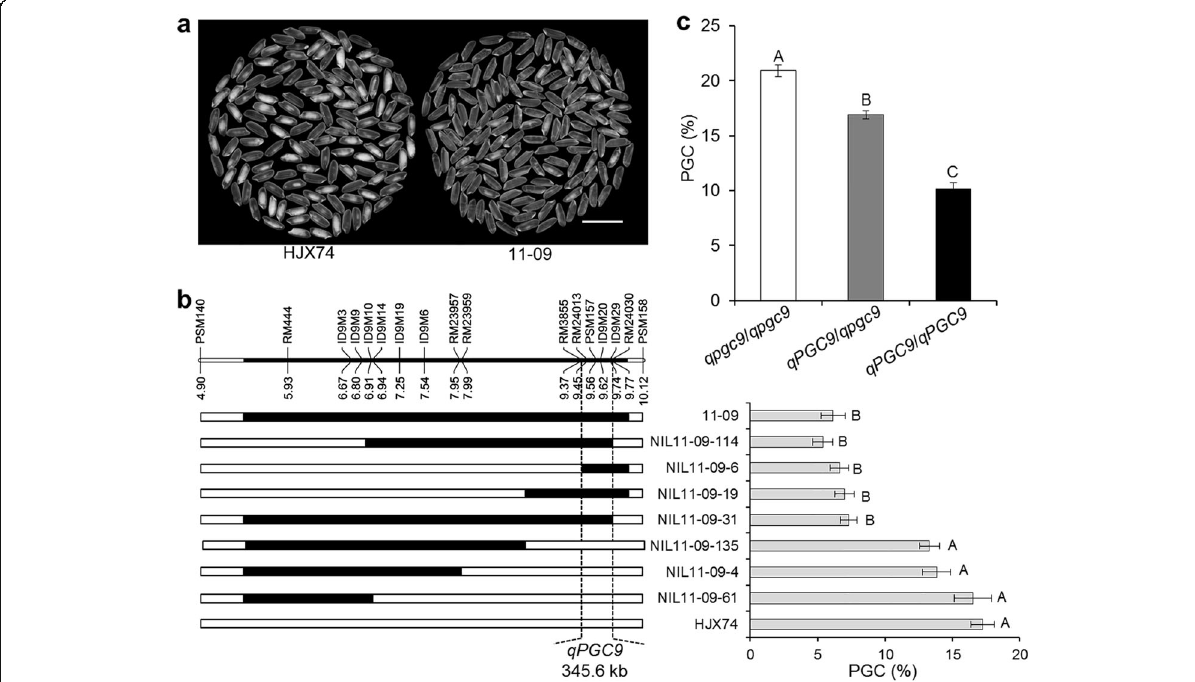
Fig. 2 Substitution mapping of qPGC9 for grain chalkiness . a , The head rice appearance of the HJX74 and 11 – 09. Scale bar: 1 cm. b , Substitution mapping of qPGC9 . The positions of substitution segments and the PGC of 11 – 09 and its NILs are shown, with HJX74 as the control. The numbers under the chromosome are physical distance (Mb). White and black blocks represent the homozygous genotypes of HJX74 and 11 – 09, respectively. c , PGC effects of three genotypes of qPGC9 in an F 2 population. qpgc9 / qpgc9 represents homozygous genotype of HJX74 ( n = 38); qPGC9 / qpgc9 represents heterozygous genotype of HJX74/11 – 09 ( n = 68); qPGC9 / qPGC9 represents homozygous genotype of 11 – 09 ( n = 34). Significant difference analysis in b and c was by one-way ANOVA, Duncan, two-tailed. Values in the lines among different letters are different at 1% level of